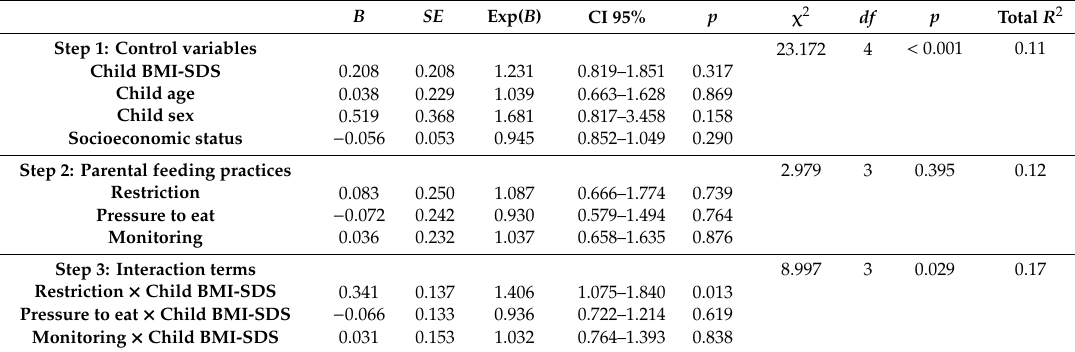
Table 4. Summary of hierarchical logistic regression analyses (full model) for the prediction of recurrent loss of control eating in children aged 11–13 years ( n =